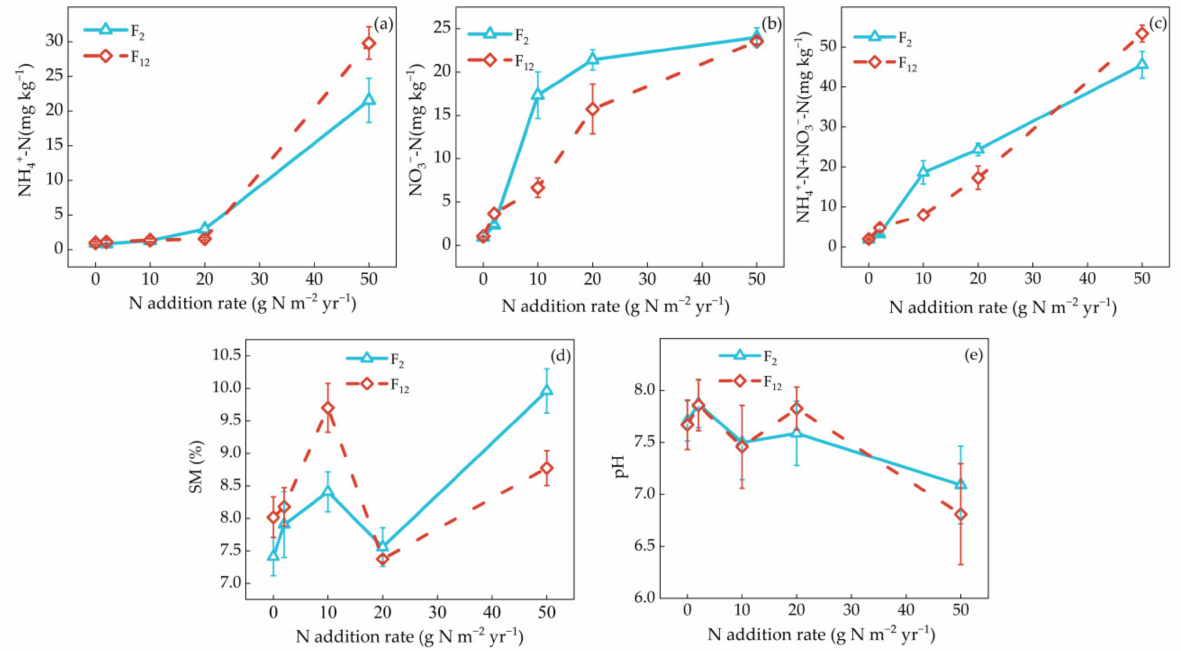
Figure 3. Effect of different frequencies of N addition on the soil NH 4+ -N concentration. ( a ) Soil NO 3 − -N concentration, ( b ) soil NH 4+ -N +NO 3 − -N concentration, ( c ) soil moisture and ( d ) pH, ( e ) soil pH under two different frequencies. Values are the means ± SE of four replications. Blue triangles with solid lines indicate 2 N additions yr − 1 (F 2 ). The red quadrilateral and dotted line indicate once a month (F 12